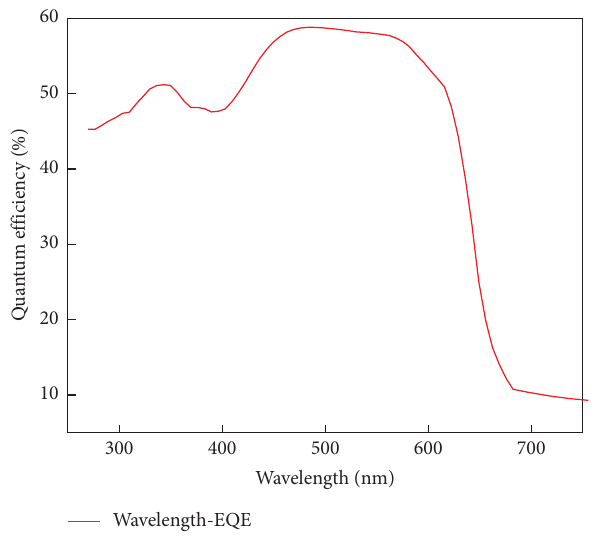
Figure 5: EQE the cell as the function wavelength.